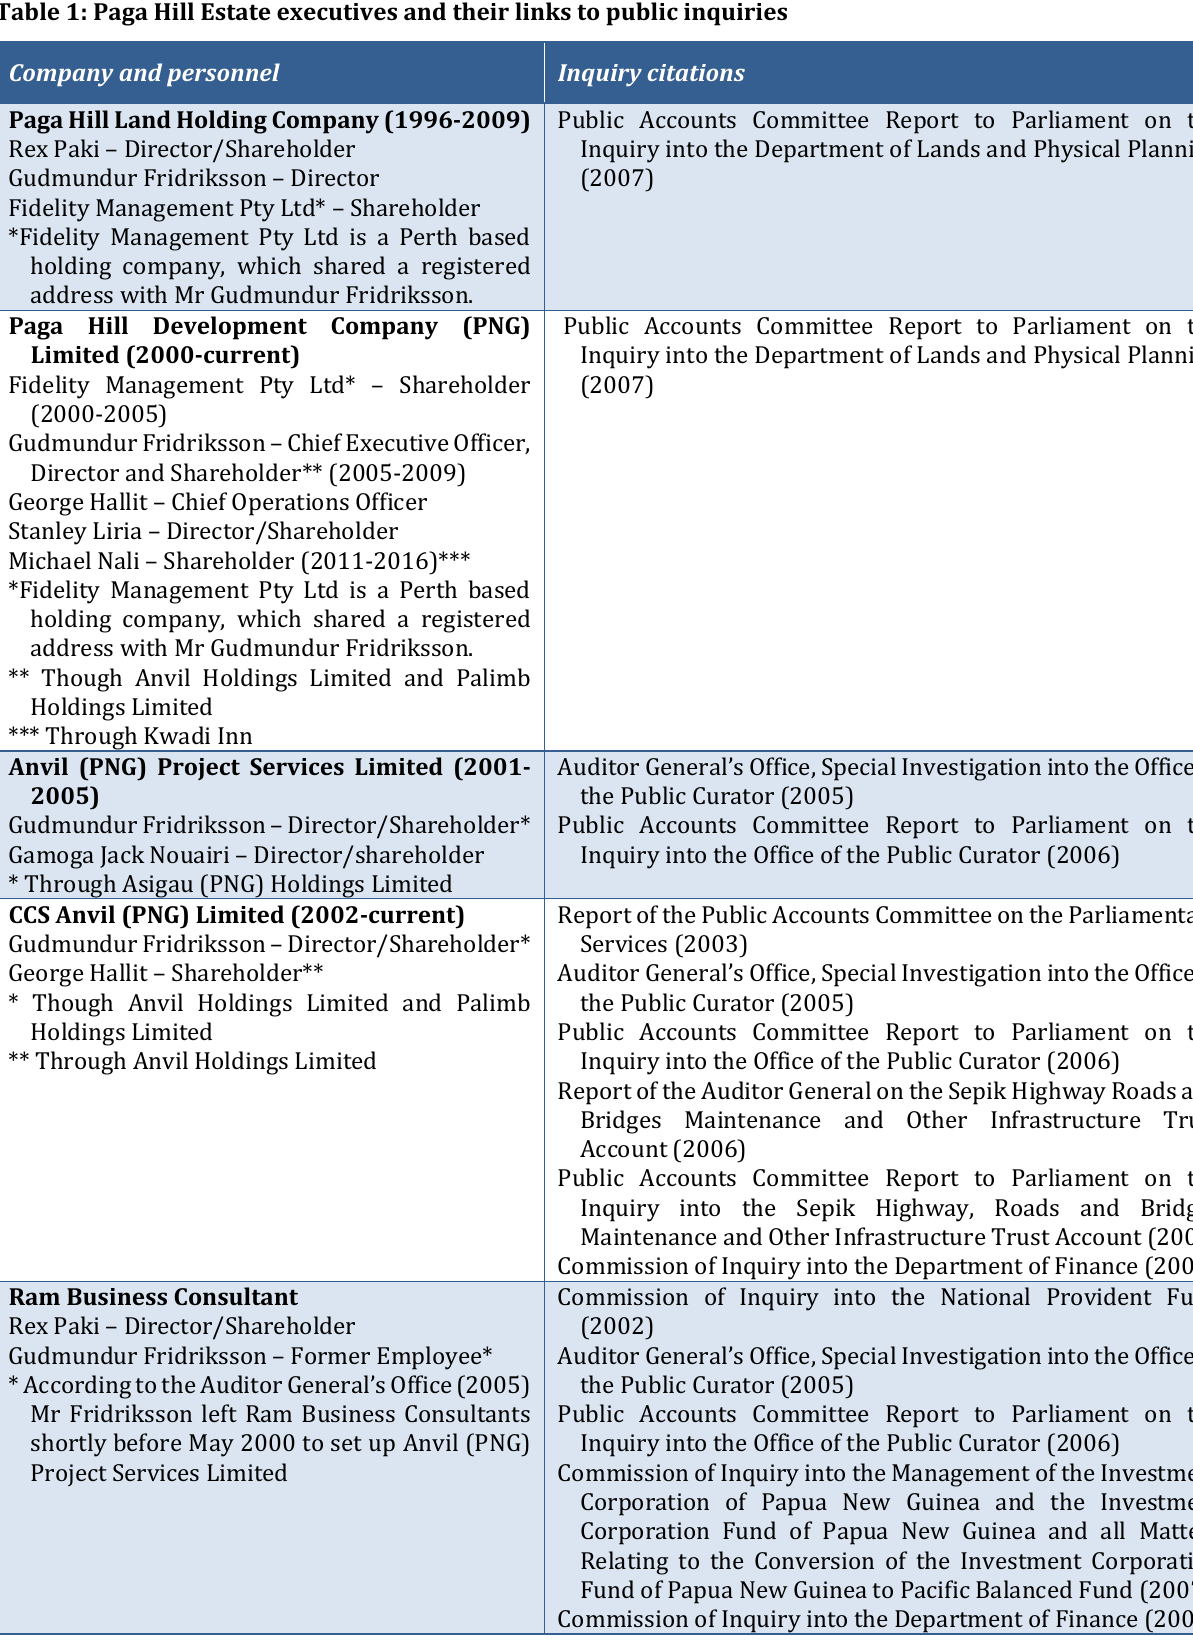
Table 1: Paga Hill Estate executives and their links to public inquiries Company and